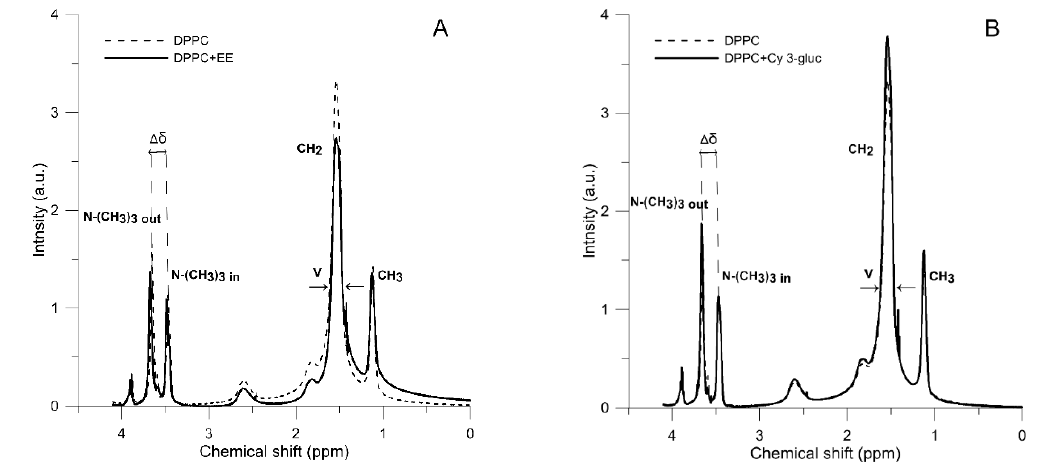
Figure 1. 1 H-NMR spectra of liposomes formed from pure DPPC liposomes and DPPC with ( A ) elderberry (EE, v / v 400:1), ( B ) Cyanidin 3- O -glucoside (Cy 3-gluc, mol/mol 100:1). PrCl 3 (4 mM) added to the samples before measurement.